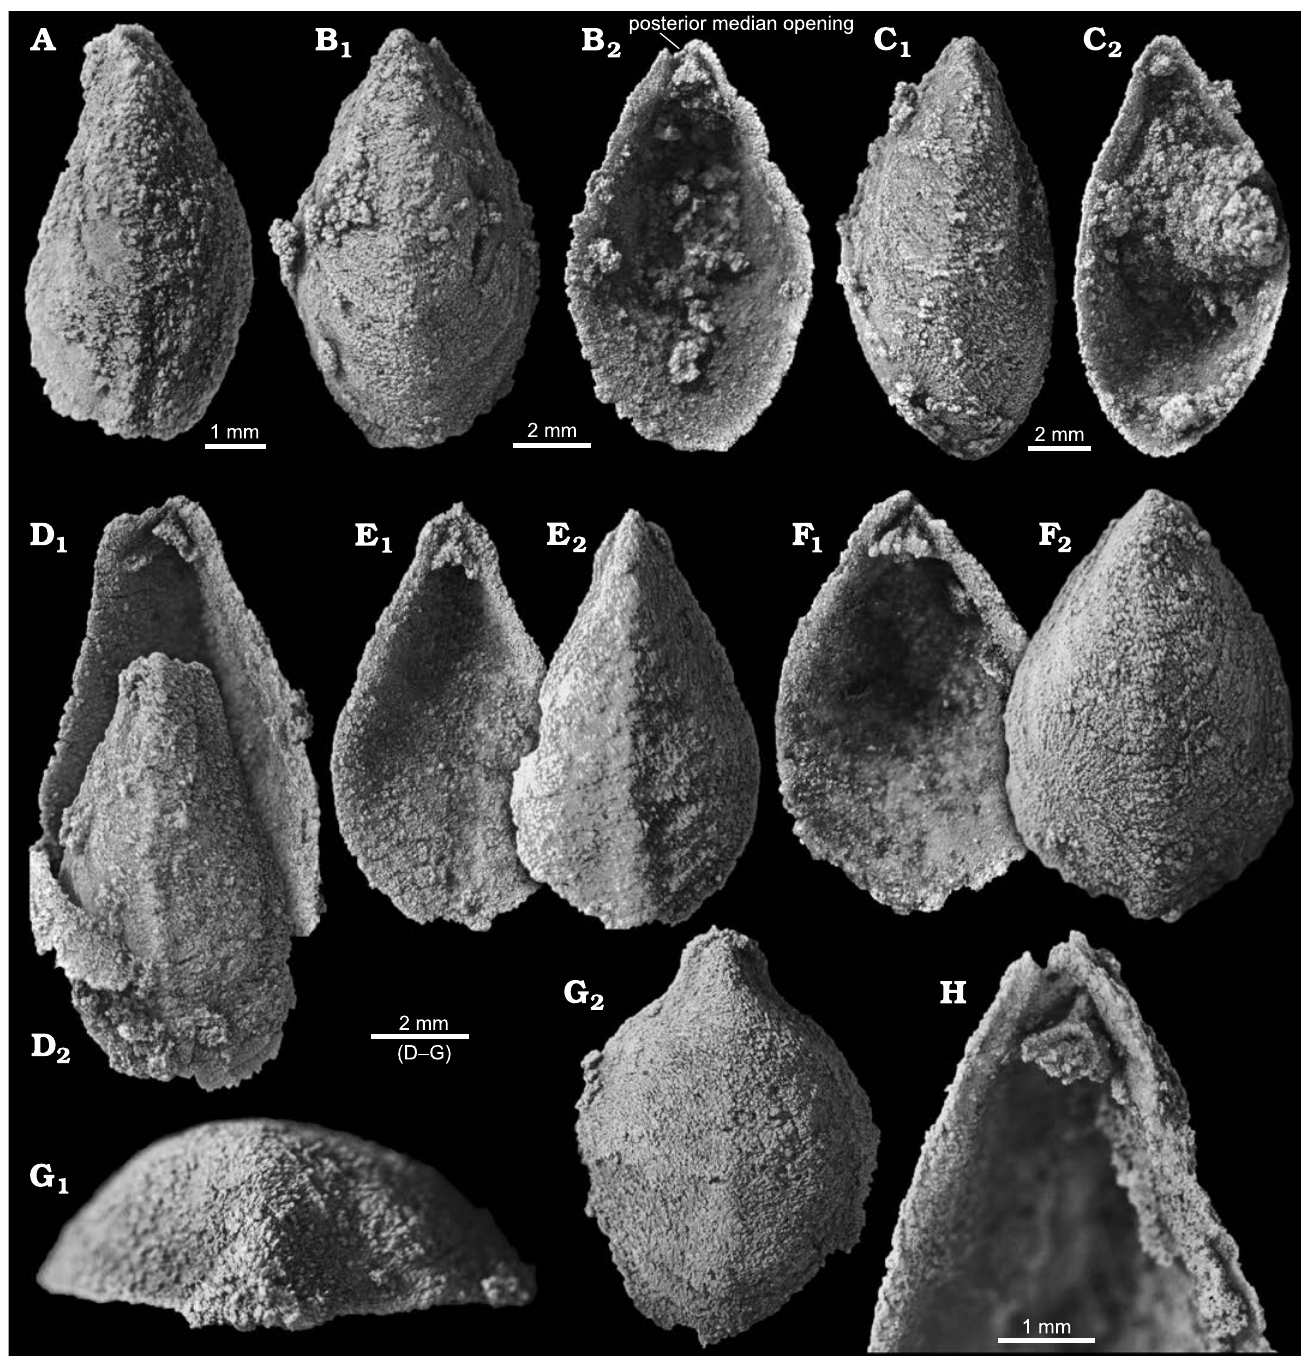
Fig. 6. Stenothecoid pan-brachiopod Stenothecoides rasettii sp. nov., middle Cambrian, Burgess Shale Formation, Yoho National Park, Canada, Locality 1 (A, D, E, G, H) and Locality 2 (B, C, F). A . TMP 2008.024.1140, ventral valve in exterior view. B . TMP 2002.083.0179, ventral valve in exterior (B 1 ) and interior (B 2 ) views. C . TMP 2002.083.0180, dorsal valve in exterior (C 1 ) and interior (C 2 ) views. D . TMP 2008.024.1145, dorsal valve in interior (magnified, D 1 ) and exterior (D 2 ) views. E . TMP 2008.024.1141, ventral valve in interior (E 1 ) and exterior (E 2 ) views. F . TMP 2002.083.0181, dorsal valve in exterior (F 1 ) and interior (F 2 ) views. G . TMP 2008.024.1146, dorsal valve in posterior (G 1 ) and exterior (G 2 ) views. H . TMP 2008.024.1139, ventral valve in interior